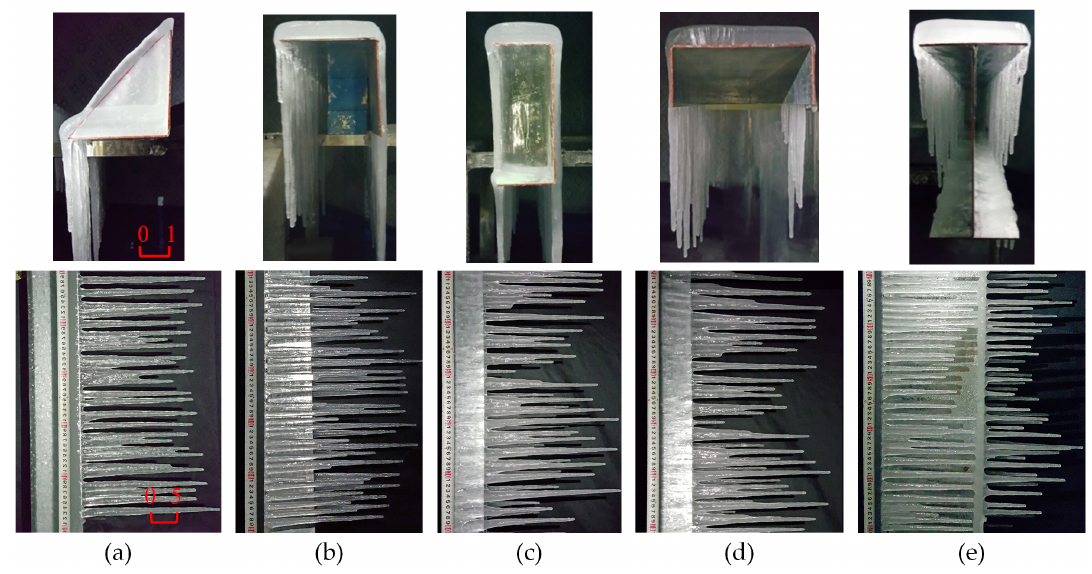
Figure 18. Profiles or side views of ice accretions for section steel ( N = 80): ( a ) L100 for γ = 0°, ( b ) L100 for γ = 90°, ( c ) U140 for γ = 0°, ( d ) U140 for γ = 90°, and ( e ) Ⅰ 200 for γ = 0°.